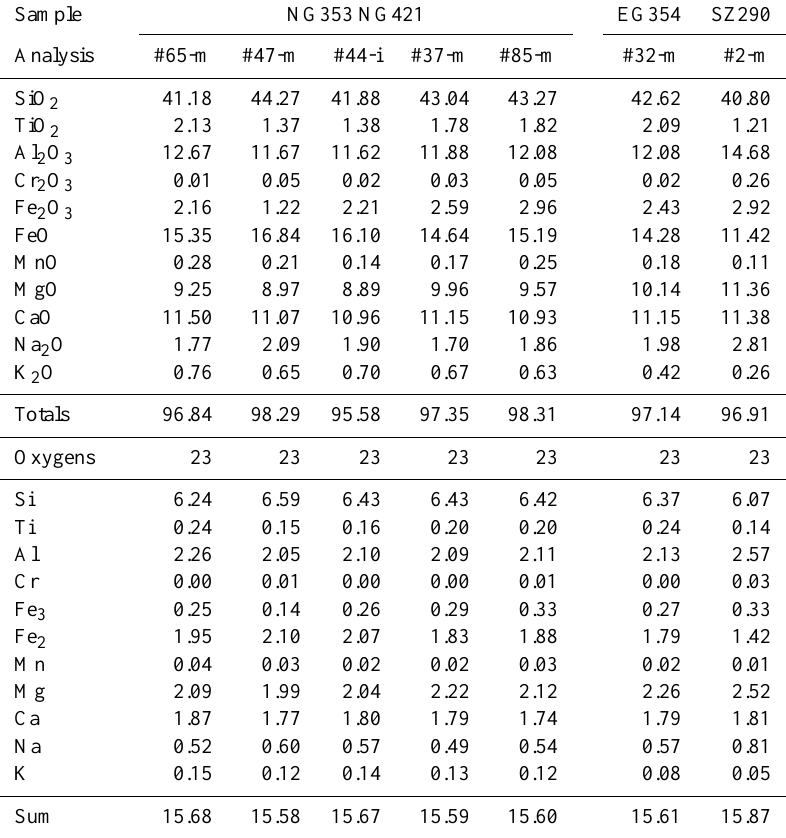
Table 4d. Representative EMPA of